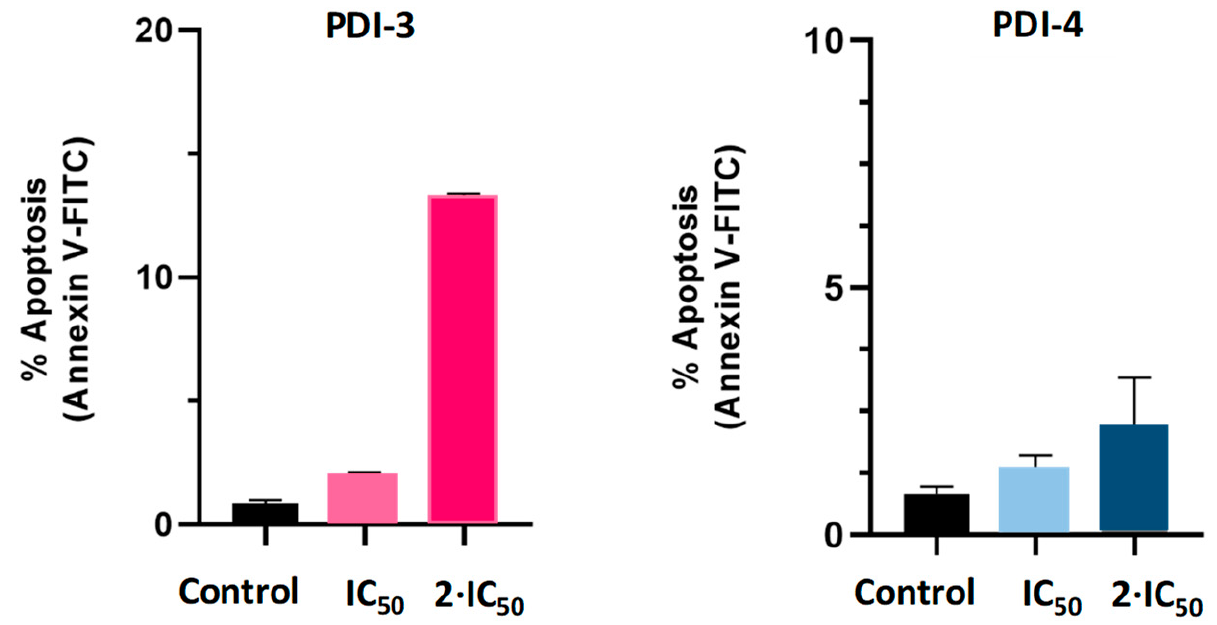
Figure 6. Cytotoxicity assays of compounds PDI-3 and PDI-4 incubated in HeLa cells for 24 h, in concentrations of IC 50 and 2 IC 50 values.